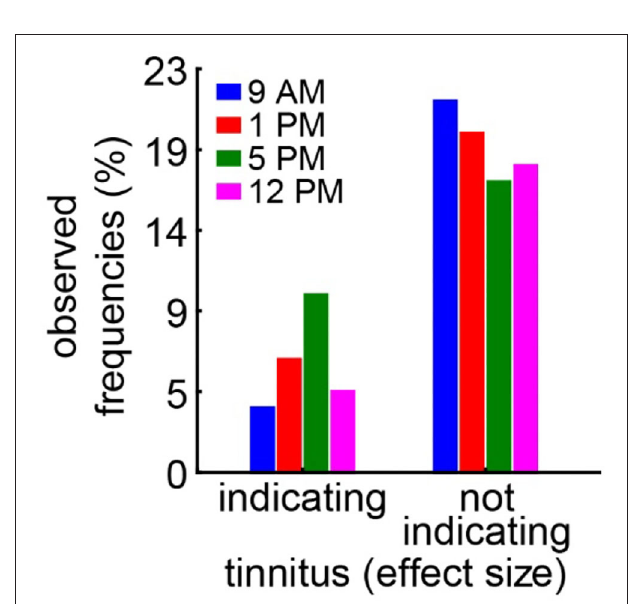
FIGURE 4 | Relative number of frequencies with or without behavioral signs of a tinnitus percept. A significantly negative effect size indicates a possible tinnitus percept and is counted as such. A chi-squared test for multiple groups ( p = 0.23) reveals no significant difference in the response